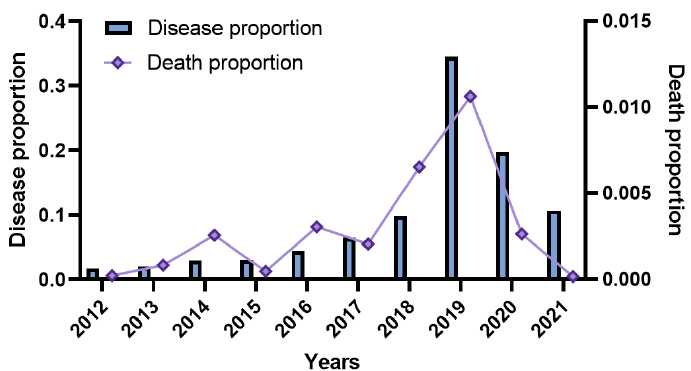
Figure 3. Proportion of influenza-like cases or related deaths to all infectious disease cases or deaths (data were obtained from the Bureau of Disease Prevention and Control) [20].